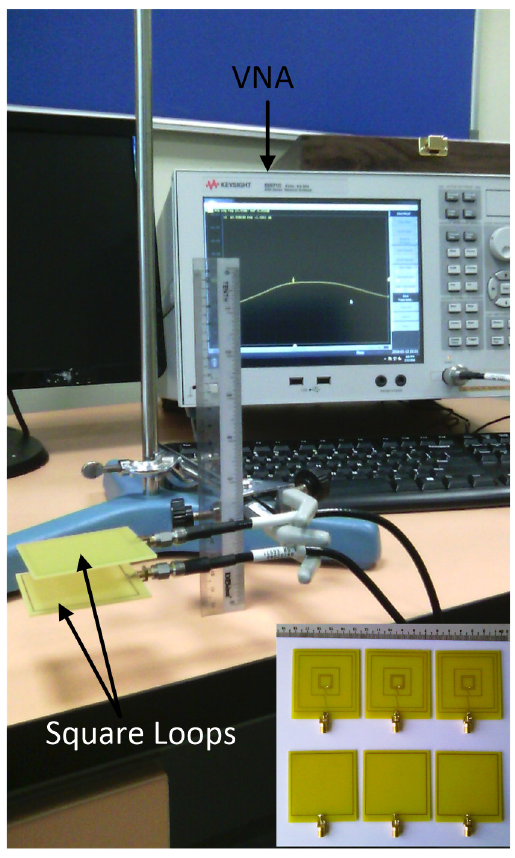
Fig 7. Experimental test